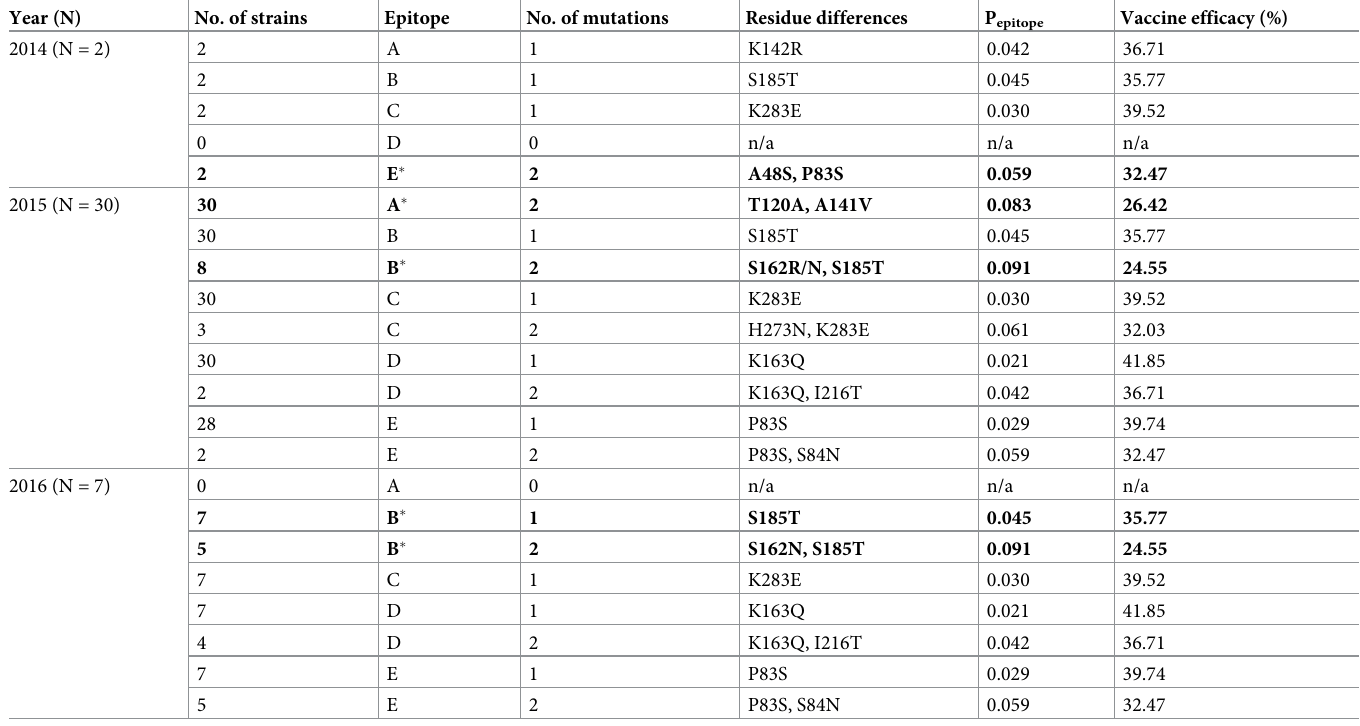
Table 1. Predicted vaccine efficacy of A/California/07/2009 vaccine strain during the 2014 to 2016 influenza seasons in Cameroon. Year (N) No. of